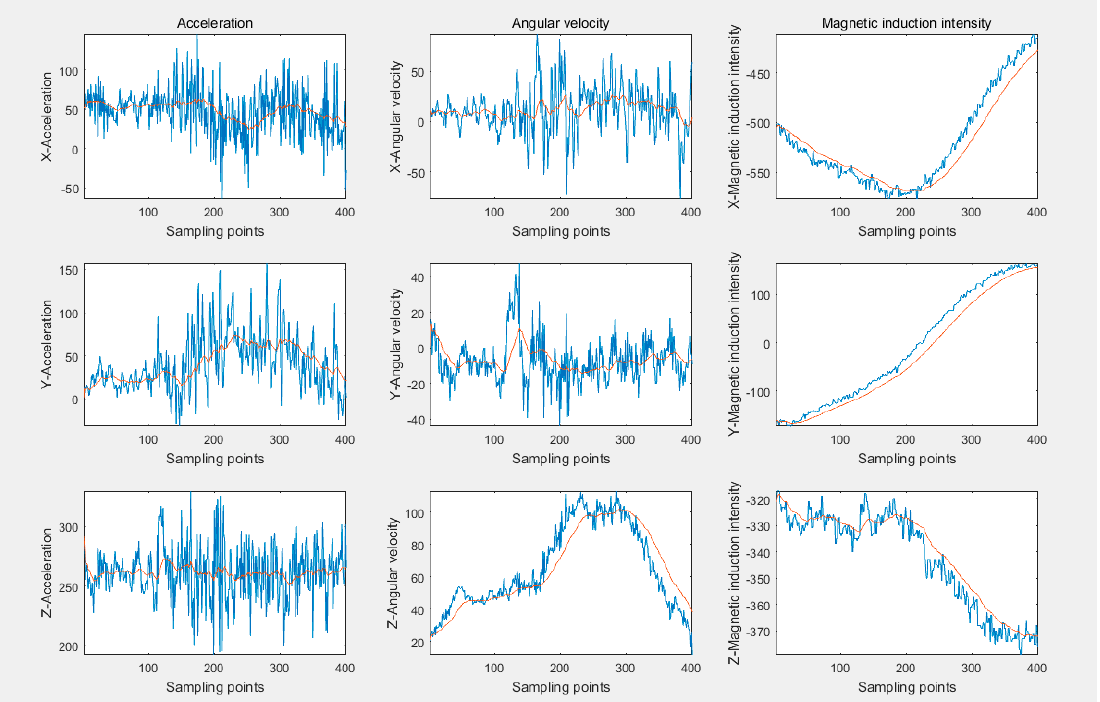
Figure 10. The performance of Kalman filter in filtering all nine-axis signals.